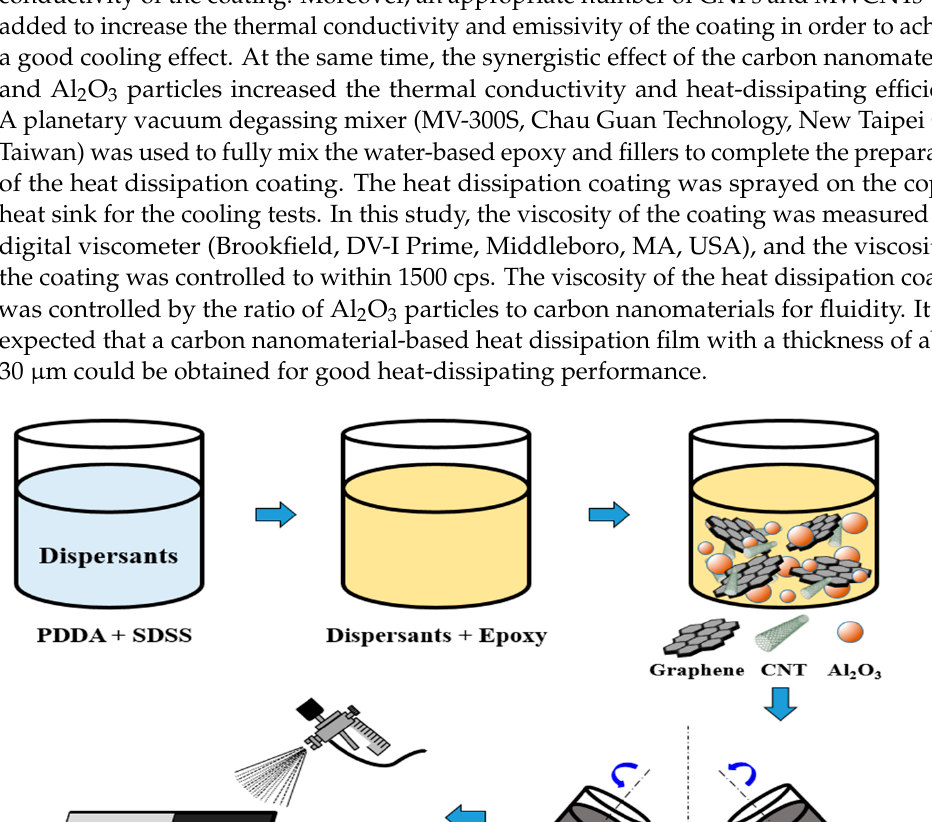
Figure 4. Schematic of the temperature monitoring system and thermal emissivity measurement.